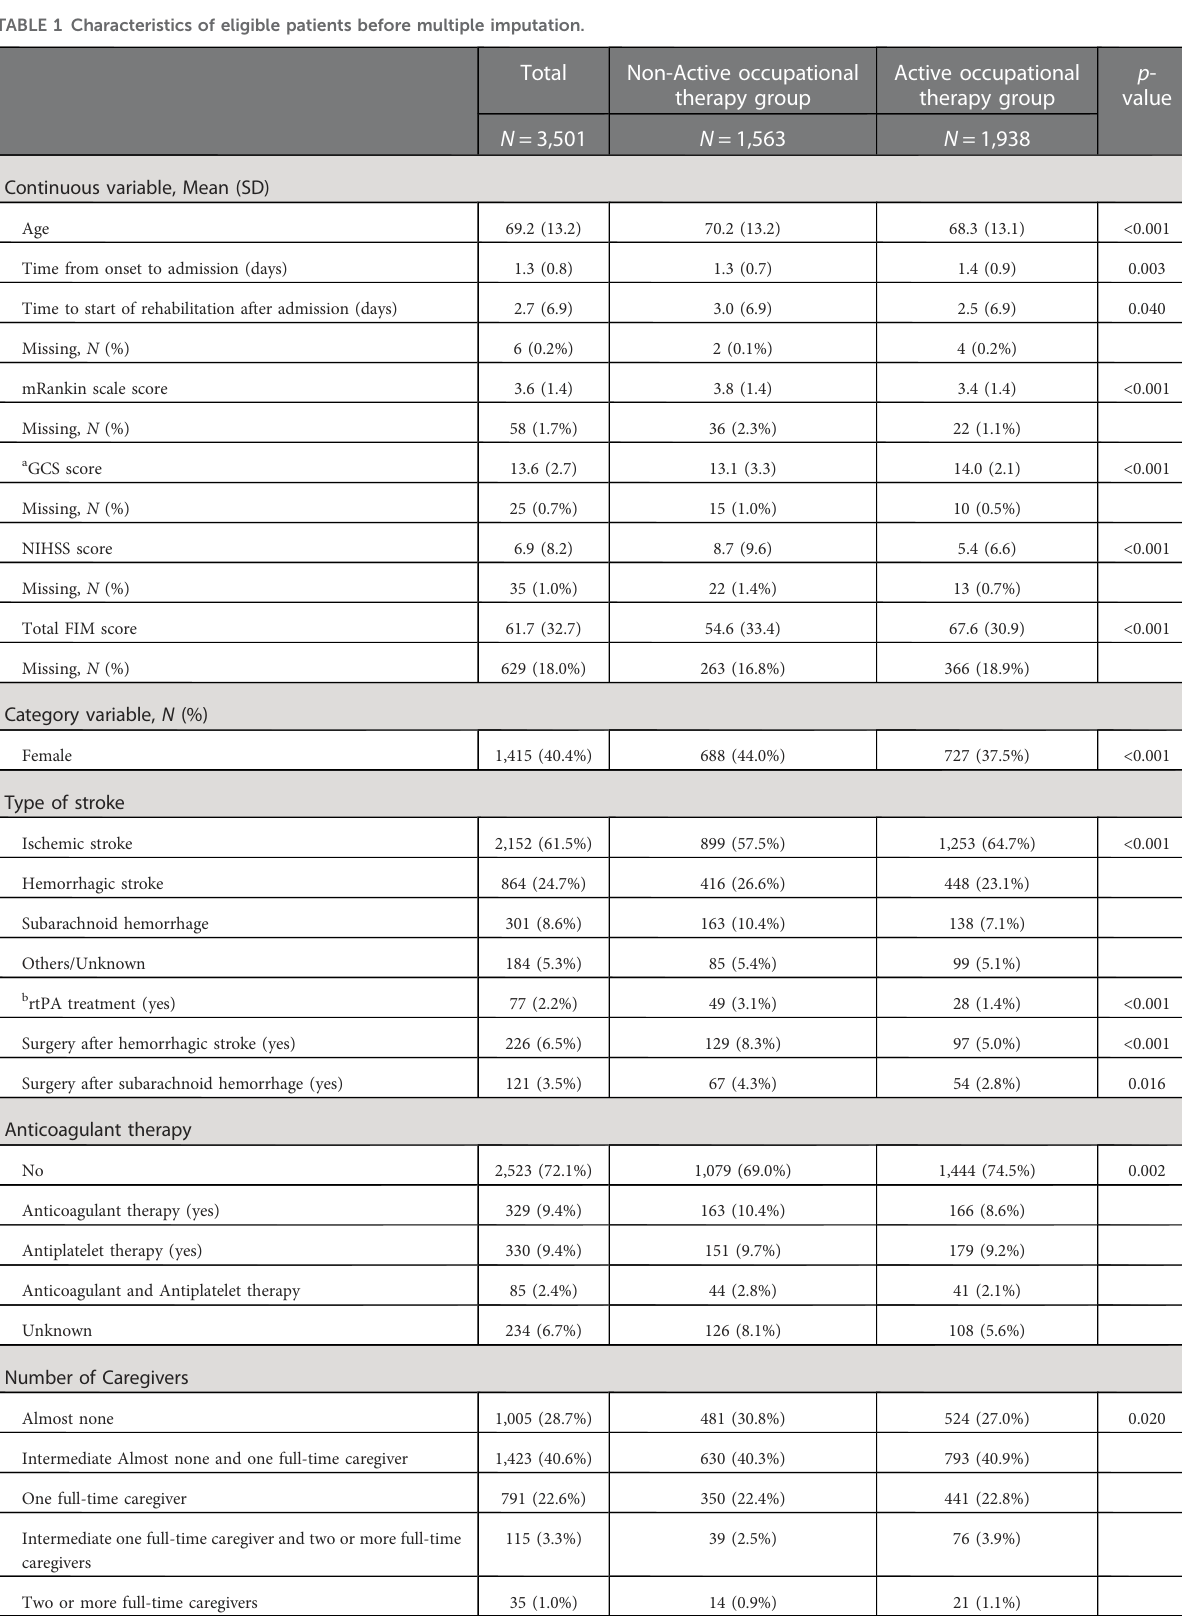
TABLE 1 Characteristics of eligible patients before multiple